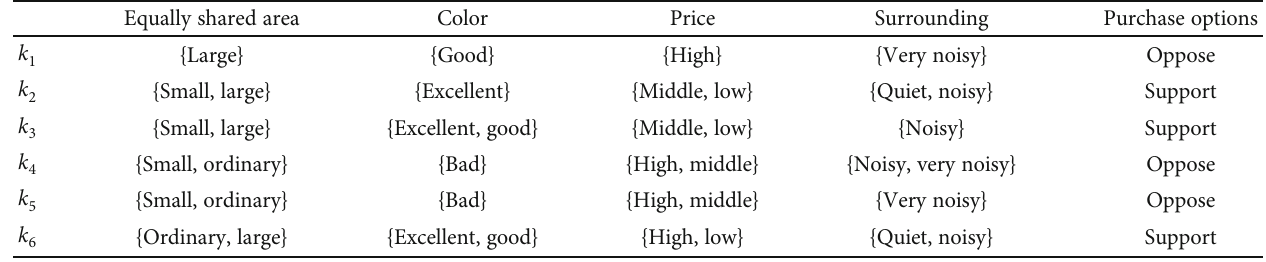
Algorithm 1: Algorithm for reduction of PM E Table 3: Table for house assessment problem.